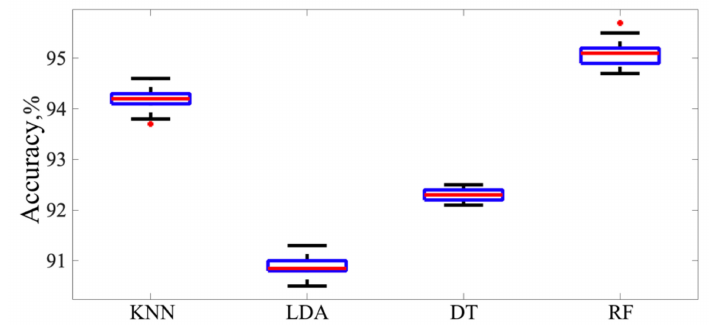
Figure 7. Boxplots of ML algorithm accuracies.